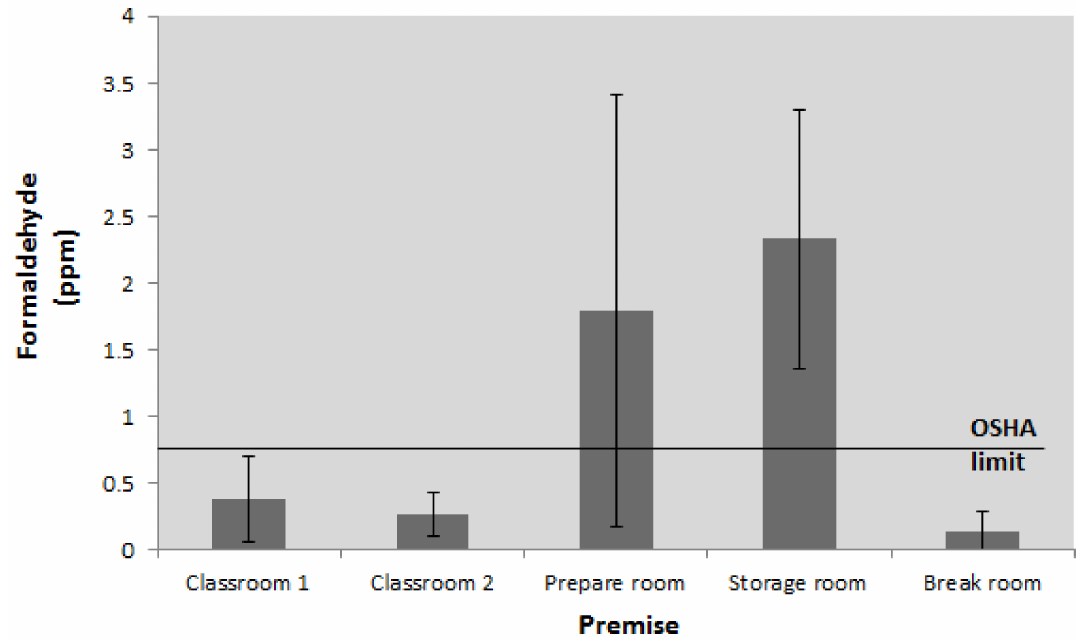
Figure 5. The average FA concentrations in different premises during the sampling